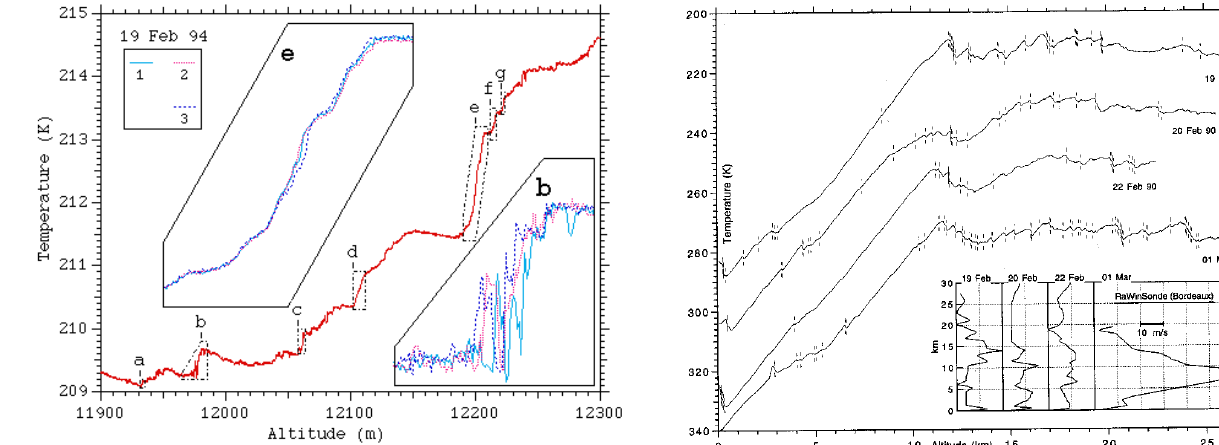
Fig. 13. Examples of temperature profiles obtained at a 20-cm ver- tical resolution during the RASCIBA90 campaign (France) (after Dalaudier et al., 1994). The selected sheets are encircled by broken lines. Two close-ups of sheets “b” and “e” are displayed with the three profiles measured by three sensors separated by 1 m at the top of a square. Some of the sheets present ongoing mixing as in sheet b.